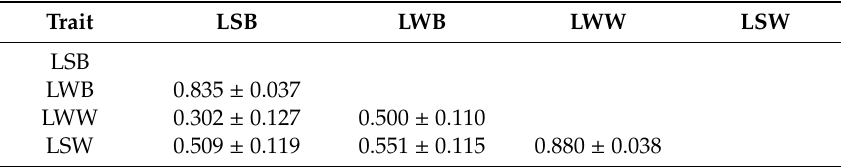
Table 2. Genetic correlations between four reproduction